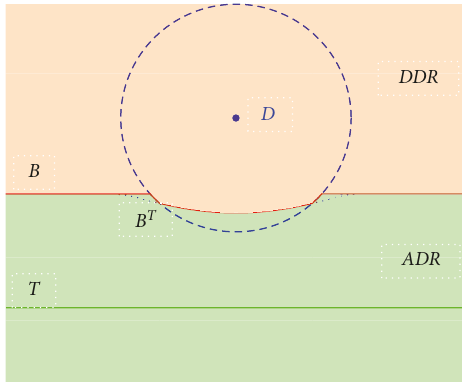
R ( 1 − α ) y R D, 0 ⩾ A and D, 0 ⩾ D .